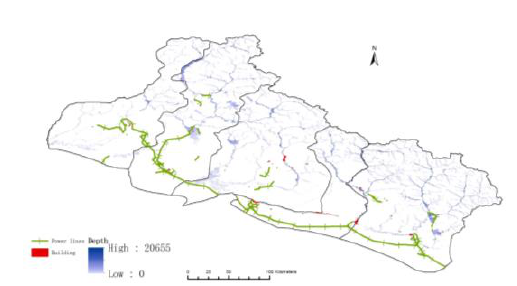
Figure 8. Settlements and buildings affected by the flood at a given time